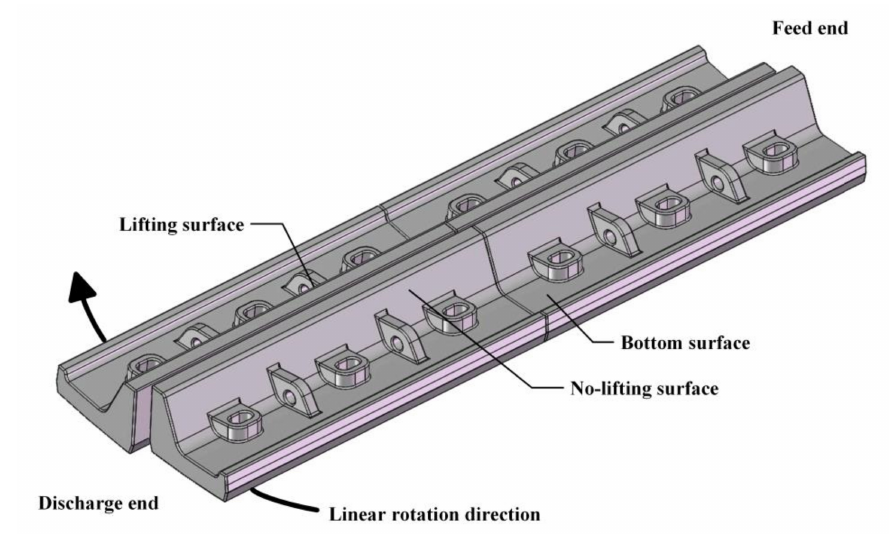
Figure 1. Arrangement model of the cylinder